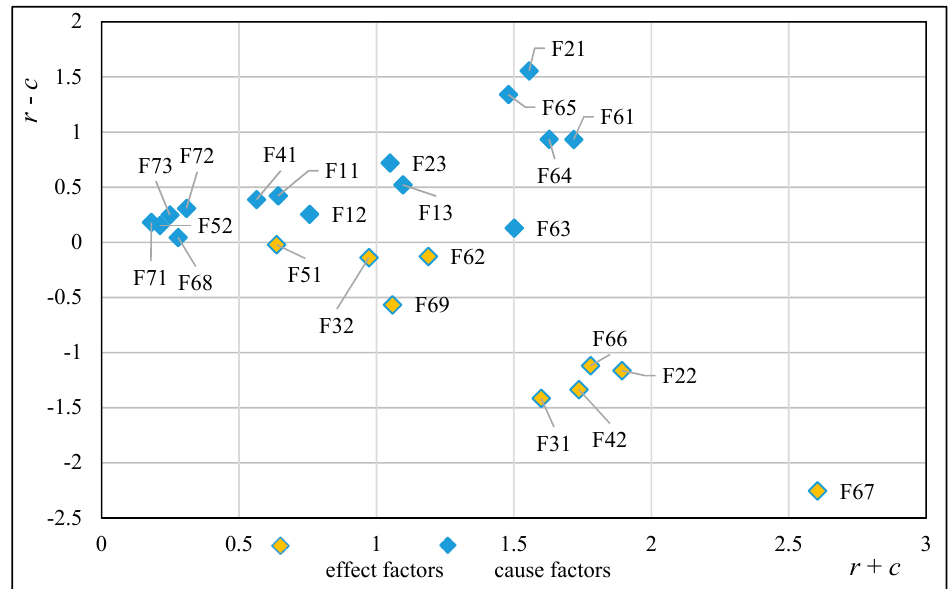
Figure 3. Causal diagram for delay factors in prefabricated construction.